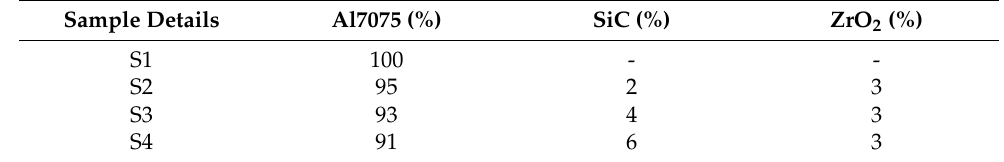
Table 8. HAMC preparation ratio [91].